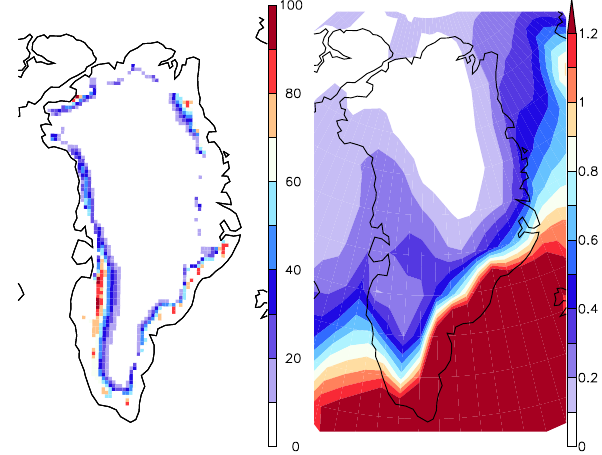
Fig. 1. Observed average duration of melt season in 1979-2007 (left, in days) (Abdalati, 2007), and average winter (DJF) precipitation in 1958-2001 from ERA-40 (right, in m/yr). As in the south, the northeastern region of the ice sheet shows a long melt season. Unlike regions in the south, however, the northeast receives very little precipitation to balance the